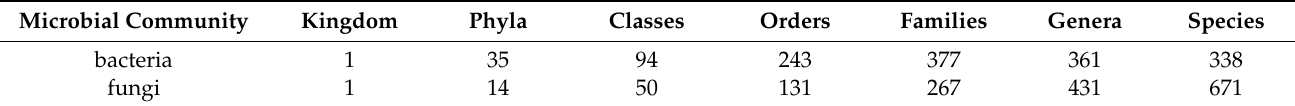
Table 6. Quantities of bacterial and fungal communities at different levels.